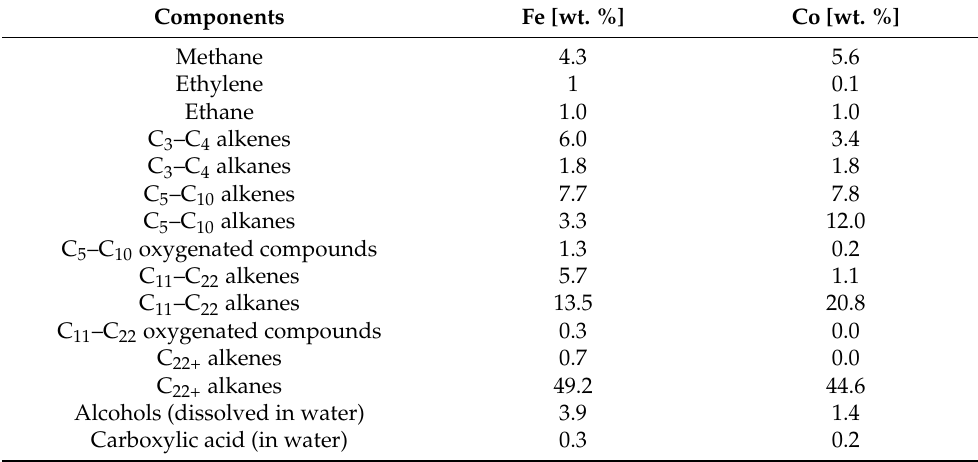
Table 1. Composition of Low-temperature FT synthesis products [21].